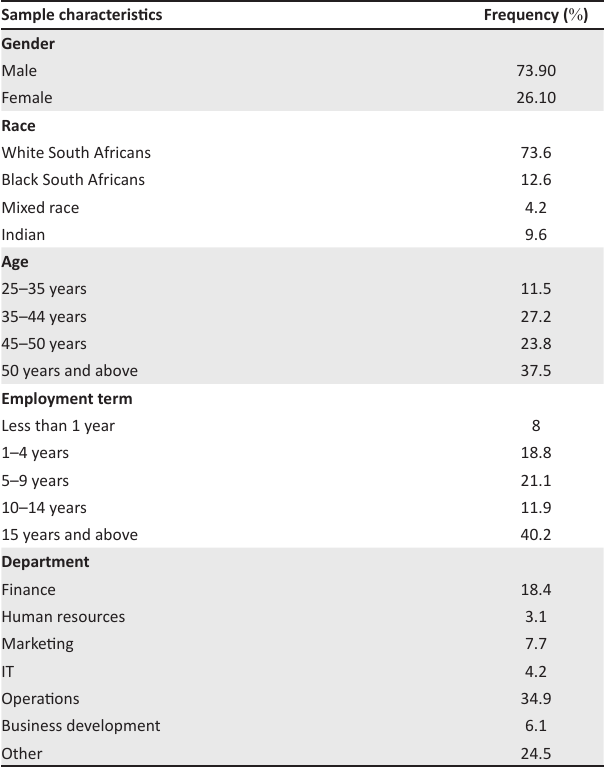
TABLE 1: Demographic characteristics of the sample. Sample